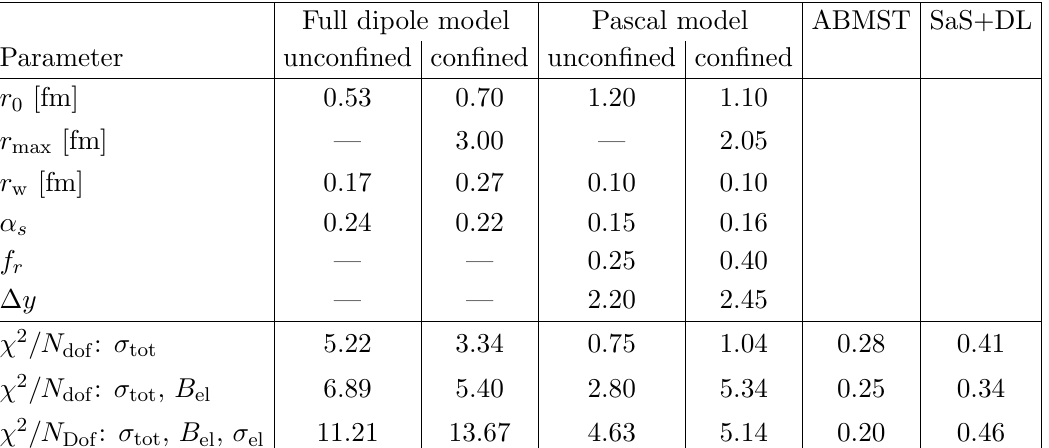
2 tot ; (cid:27) el ; B el data set and the (cid:31)